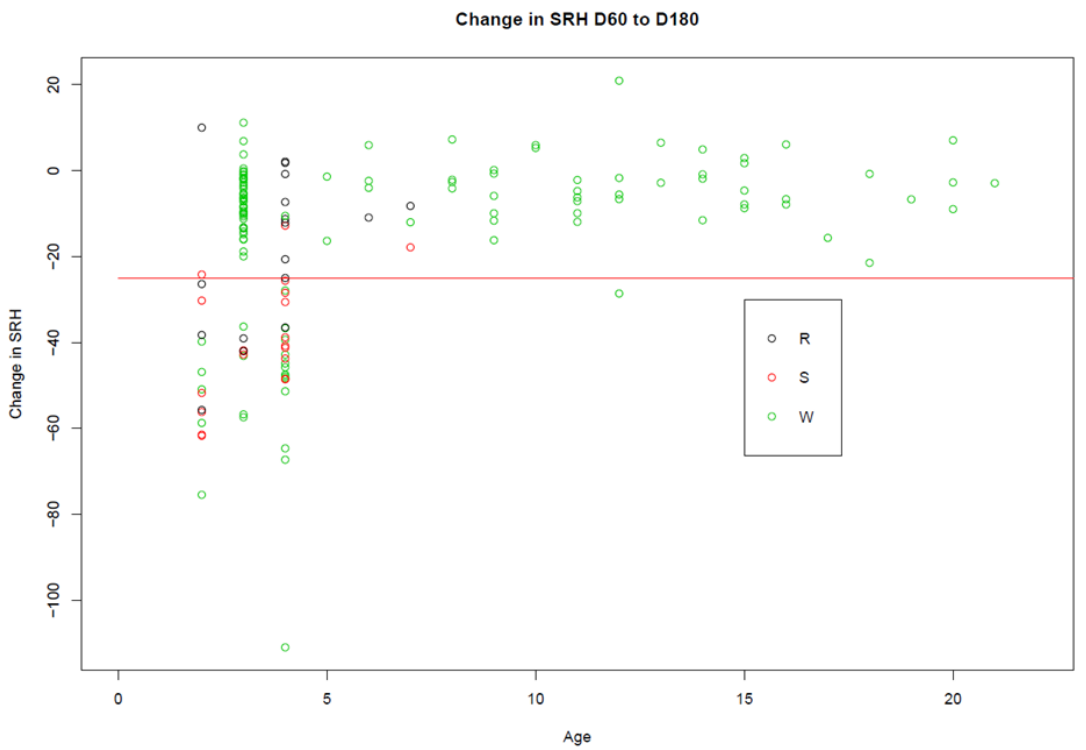
Figure 7. The change in SRH antibody titres between days 60 and 180. The black circles represent the horses vaccinated with the recombinant vaccine (R), the red circles represent the horses vaccinated with the subunit vaccine (S), and the green circles represent horses vaccinated with the whole inactivated vaccine (W). The red horizontal line is drawn at −25 mm 2 , as a decrease of ≥ 25 mm 2 is considered significant.